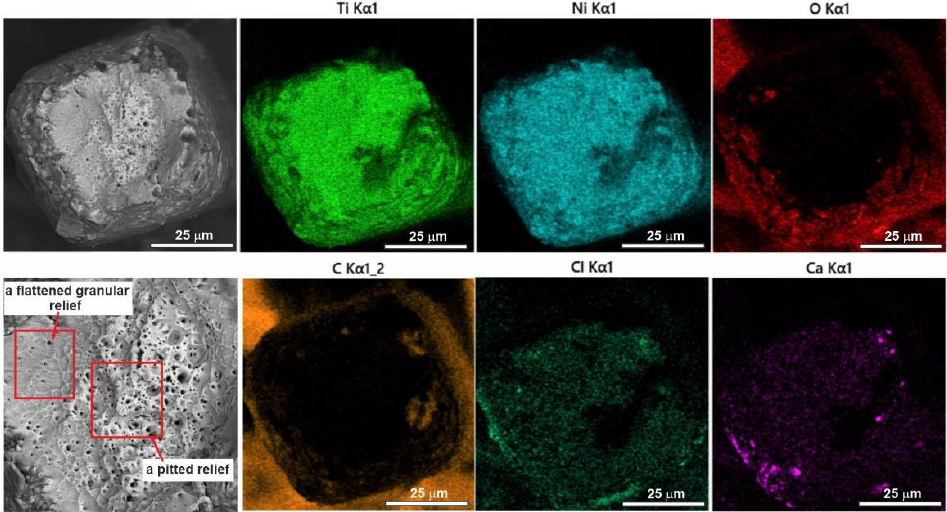
Figure 6. Mapping of the fracture surface elements of TiNi wire.